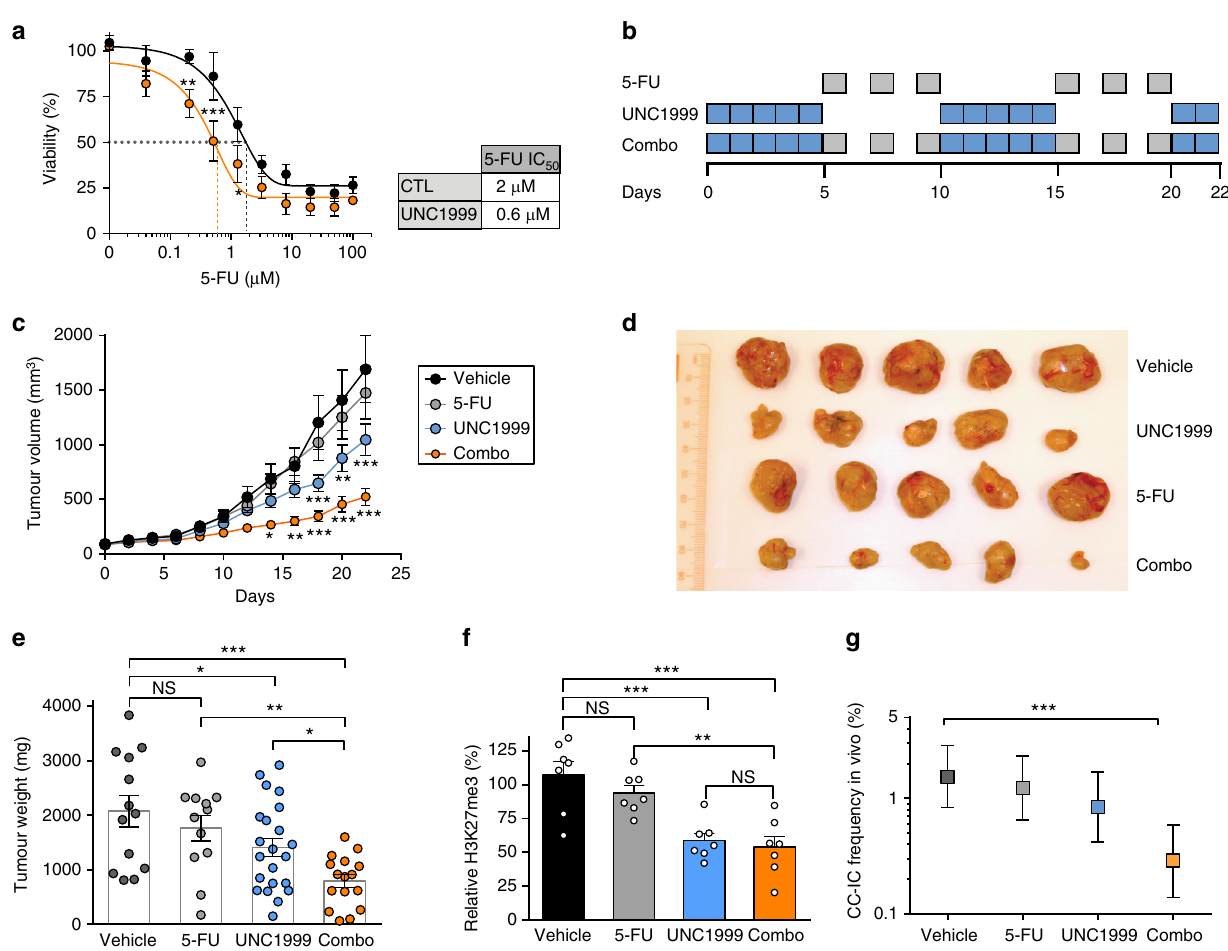
Fig. 6 UNC1999 treatment in vivo increases chemosensitivity to 5-Fluorouracil. a POP92 in vitro combination of UNC1999 (3 µ M) and increasing doses of 5-FU. Cells were pretreated with UNC1999 (3 µ M) for 3 days, after which 5-FU was added and cells incubated for 4 additional days. Viable cell count was measured and samples normalised to their respective control. Data shown are mean ( n = 4, ±SEM, two-way ANOVA). Table shows shift in 5-FU IC 50 in UNC1999-pretreated cells. b Sequential treatment of UNC1999 (300 mg/kg, oral gavage) and 5-FU (15 mg/kg, IP). Mice were dosed with either vehicle, UNC1999 alone, 5-FU alone, or 5-FU and UNC1999 in combination (Combo): 10-day cycles starting with UNC1999 for 5 days, followed by 5-FU every other day for 5 days. c Tumour size was measured over time. Data represent mean ± SEM of n = 13 tumours (vehicle), n = 12 (5-FU), n = 22 (UNC1999) or n = 15 (combo), two-way ANOVA compared to vehicle alone. d Xenografts collected from the mice treated in ( c ). e Tumour weight measurements of the xenografts collected in ( c ) and shown in ( d ). Data represent mean ± SEM of n = 13 tumours (vehicle), n = 12 (5-FU), n = 22 (UNC1999) or n = 15 (combo), one-way ANOVA. f Quanti fi cation of the reduction in H3K27me3 by western blot. Data shown are n = 7 tumours ± SEM, one-way ANOVA. g In vivo LDA performed with xenografts collected in ( c ). Data shown are represented as mean ± 95% con fi dence interval. Frequency and statistics were computed